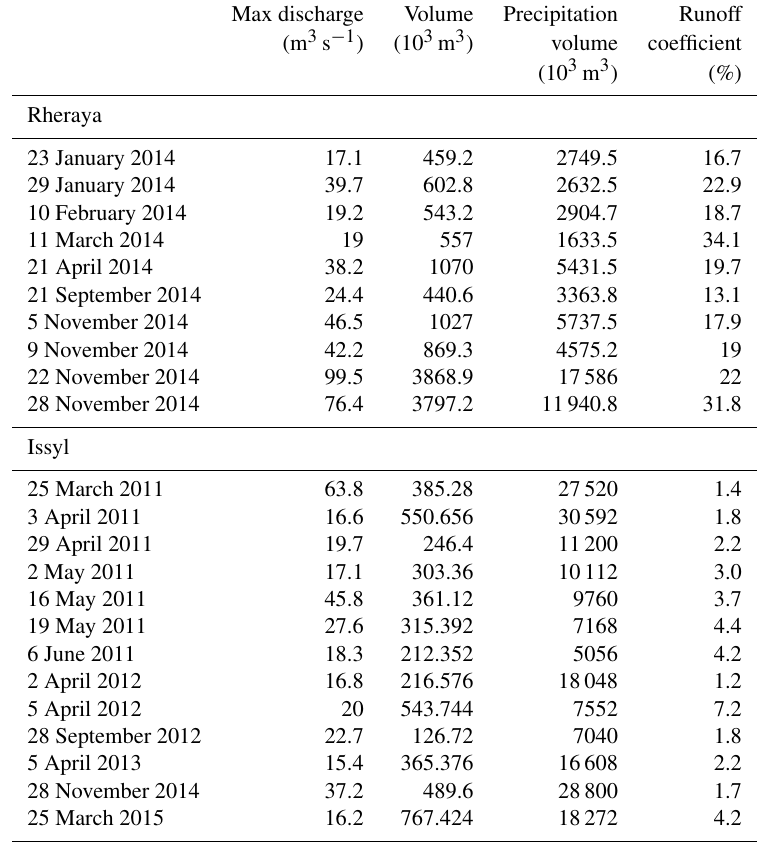
Table 2. Characteristics of the selected flood